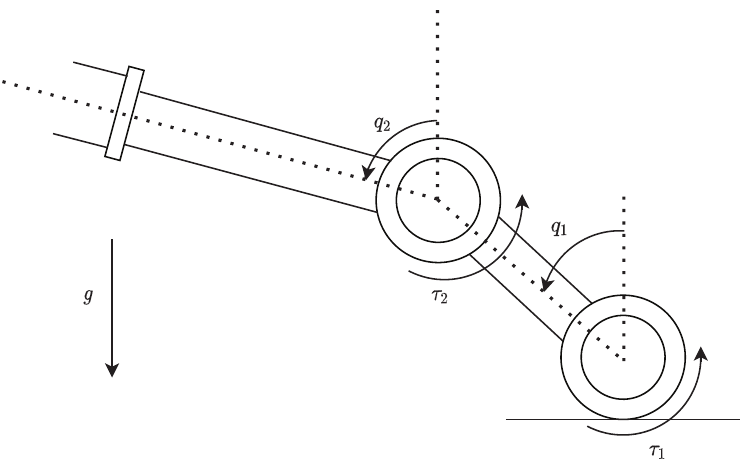
Figure 8. Two-link robot manipulator